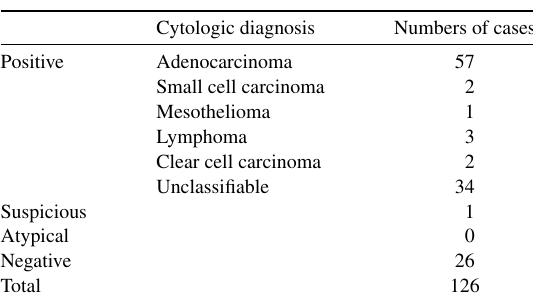
Cytologic diagnosis of effusion